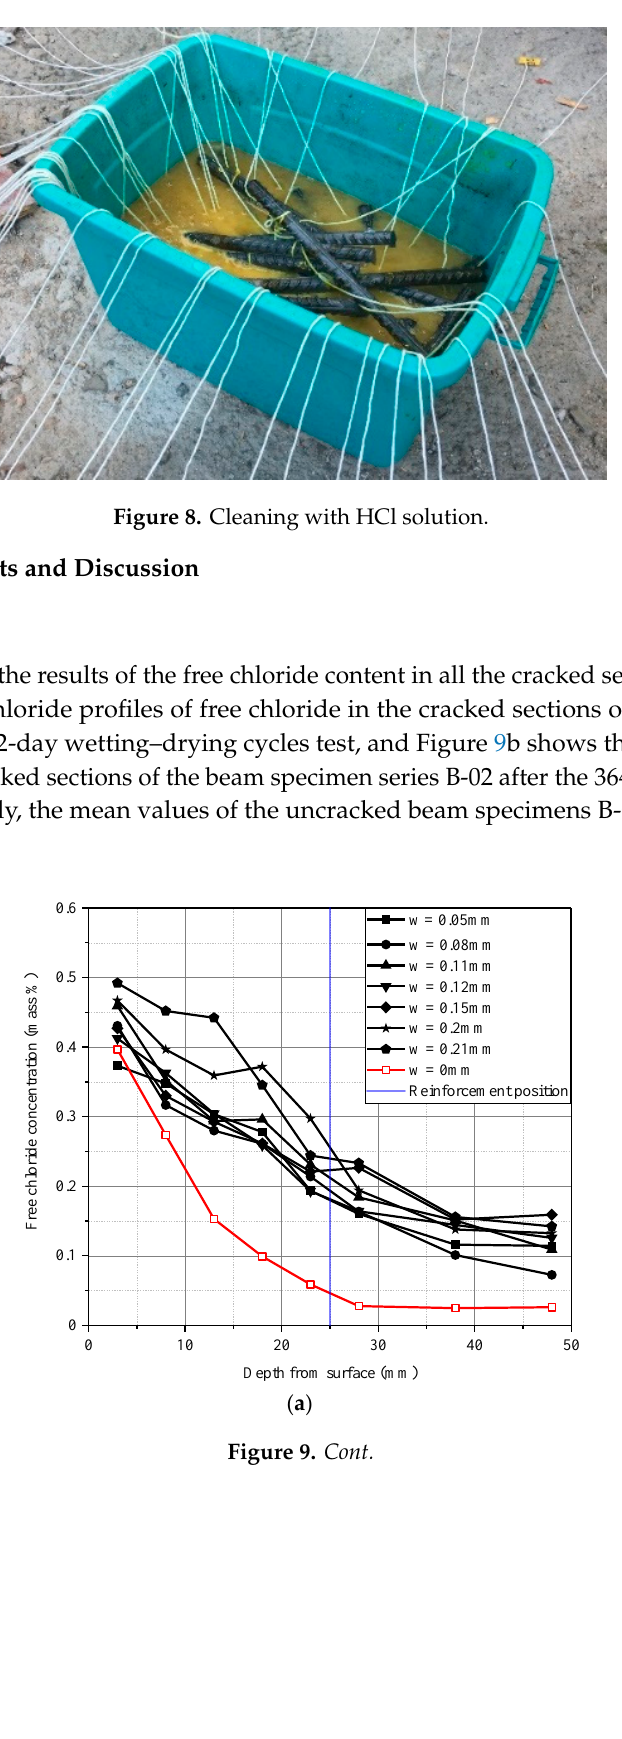
Figure 8. Cleaning with HCl solution.